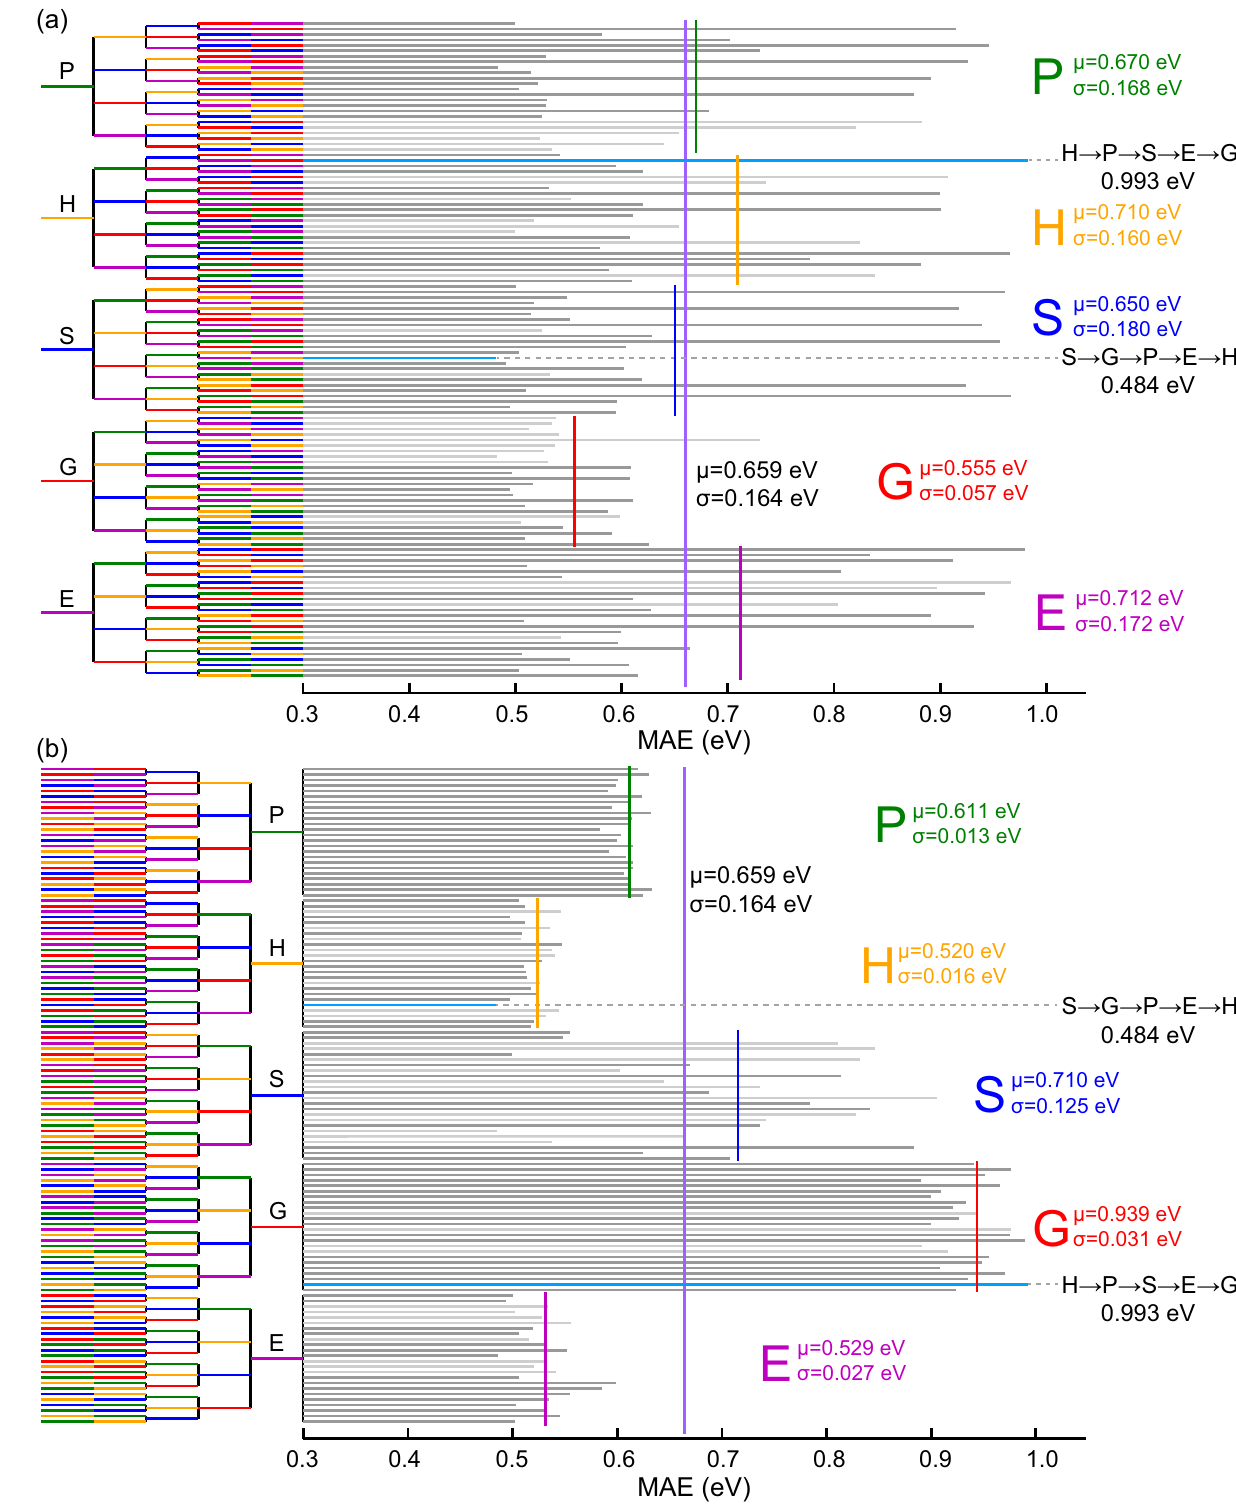
Fig. 5 MAE results on the raw data using one-by-one training approach. All possible dataset sequences are gathered a according to the fi rst dataset used and b following the last dataset used. The global average of the MAE is shown by a vertical solid purple line ( μ = 0.659 eV), while the group averages are indicated by their corresponding color (P in green, H in orange, S in blue, G in red, and E in magenta). The corresponding standard deviations ( σ ) are also indicated accordingly. The best and worst training sequences are highlighted in light blue. The training sequences that produce NaN for one of the folds (so the MAE is only that of the other fold) are indicated by a lighter gray bar, while those that lead to NaN for both folds are left